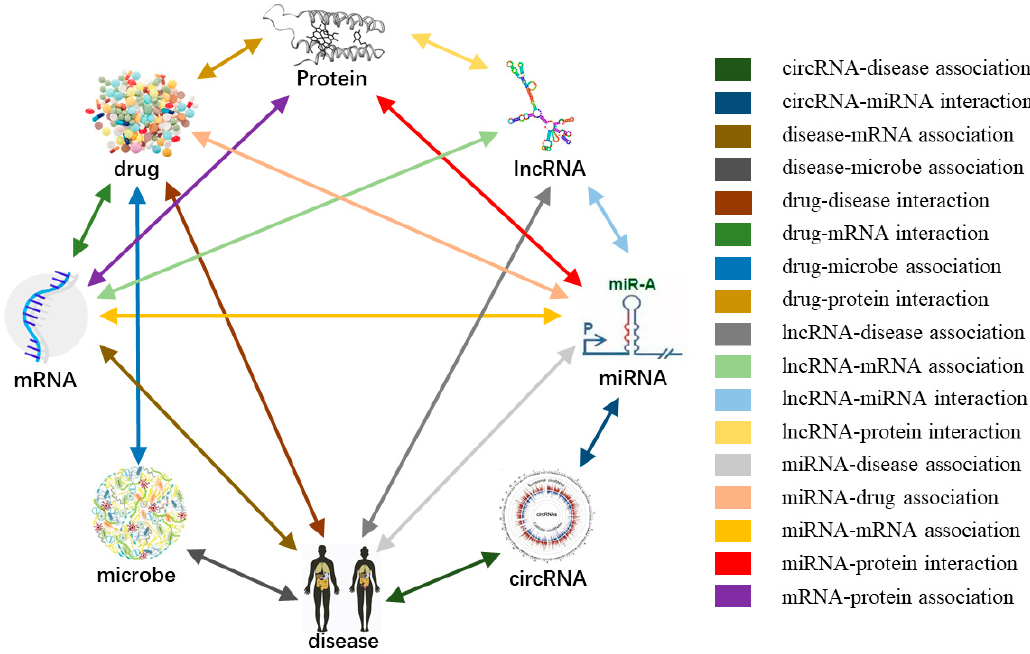
Figure 2. Systematic integration of multiple associations between biomolecules to construct the molecular association network.